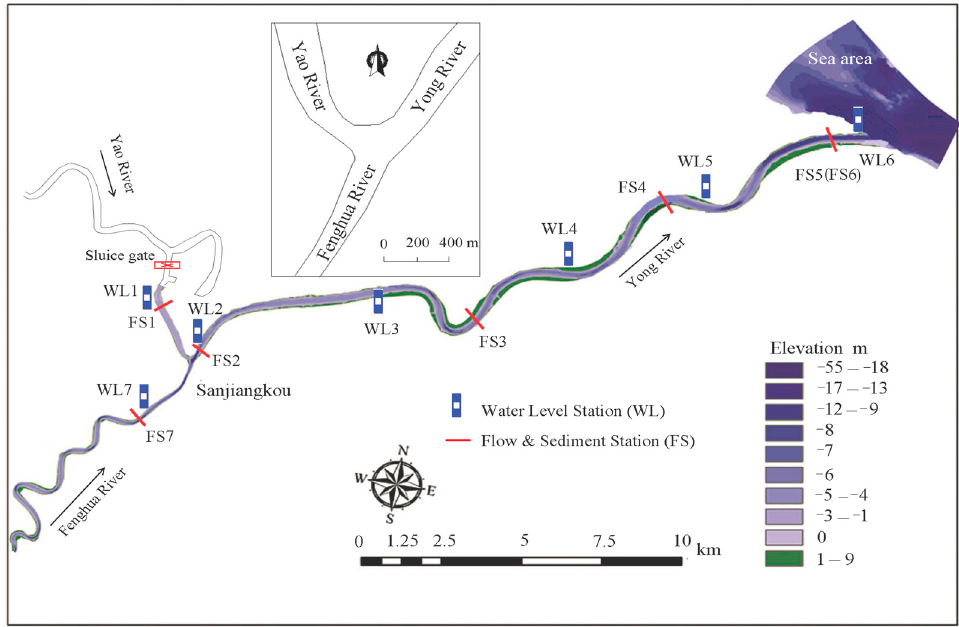
Figure 1. The water system, locations of the river confluence, and hydrological stations of water levels (WL) and of flow and sediment (FS).